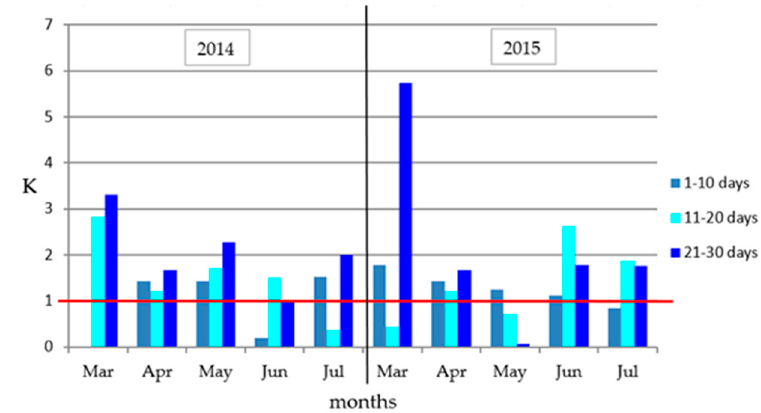
Figure 1. Value of Sielianinov’s hydrothermal coefficient in study years. Interpretation: K > 1.5 indicates excessive moisture for all plants, K = 1.0–1.5 indicates sufficient moisture, K = 0.5–1.0 indicates insufficient moisture and K < 0.5 indicates moisture less than the requirement for most of plants (drought).